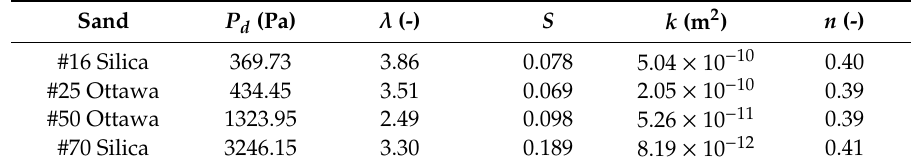
Table 4. Brooks–Corey model parameter for heterogeneous sand lenses in parallel plate cell.